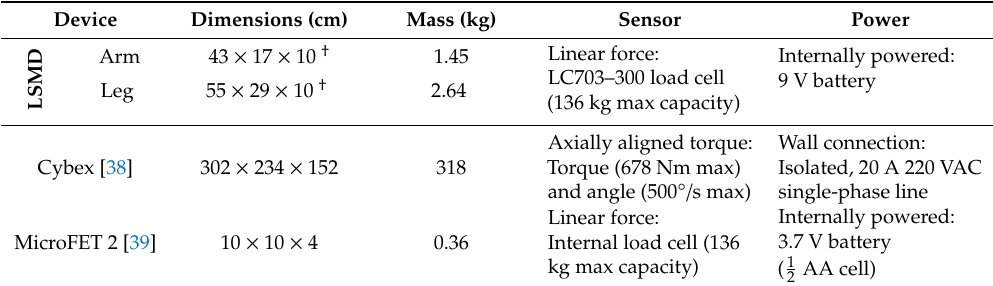
Table 1. Comparison of specifications for LSMD, Cybex Isokinetic Dynamometer and MicroFET 2 Hand-held